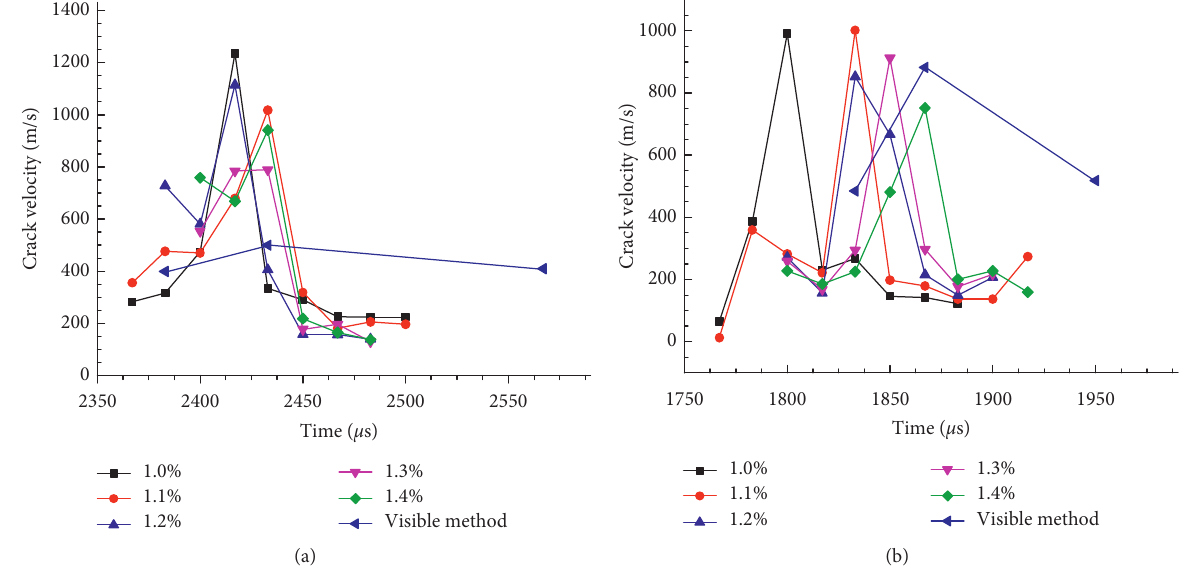
Figure 14: Crack velocity. (a) Test 1 and (b) test